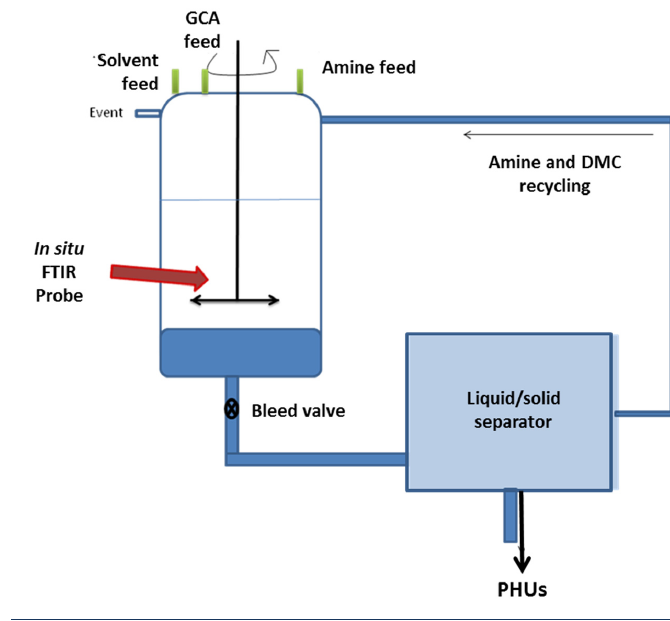
Figure 3. Batch process scheme for the synthesis of high-molecular-weight glycerol amino ethylene ester PHUs.